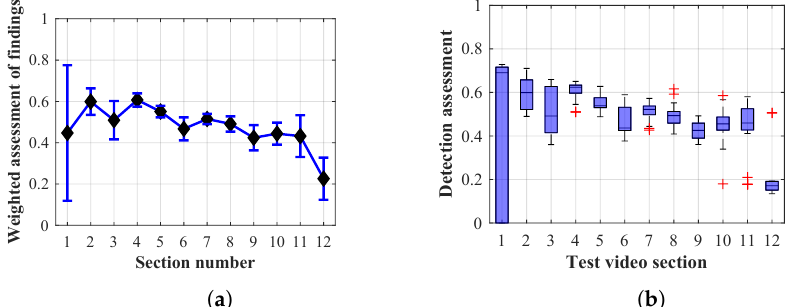
Figure 31. ResultsofMethod1.2withalifespanof12frames. ( a )theweightedaverageratingwiththeaverage mean absolute error of the weighted rating and ( b ) boxplots of the distribution of the statistical sets of the results of the individual sections evaluated indicating: minimum, 1st quartile, median, 3rd quartile, maximum.